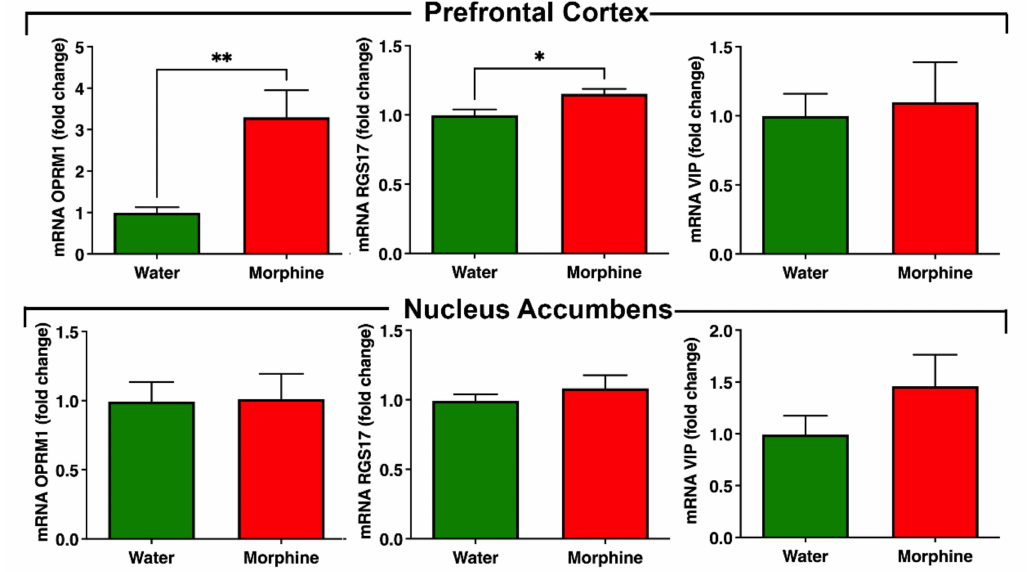
Figure 8. Voluntary morphine intake induces an increase in opioid receptor mRNA levels in pre- frontal cortex but not in nucleus accumbens of Wistar rats. mRNA levels of the morphine receptor OPRM1 and the accessory proteins RGS17 and VIP were determined by RT-qPCR in pre-frontal cortex and nucleus accumbens of rats that had voluntarily ingested morphine solutions for four weeks. Animals drinking only water were used as controls. Expression levels were determined by the ∆∆ CT method and normalized against the mRNA levels of the housekeeping genes GAPDH and Hprt1 in the same sample. Data are expressed as mean ± SEM. n = 8 in each experimental group. * p < 0.05; ** p < 0.01, two-tailed Student t